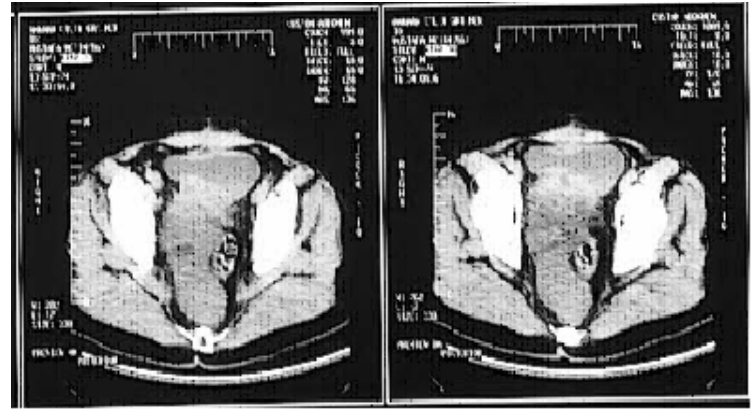
FIGURE 2 . Localization of retrovesical mass and impression of it to adjacent organs on